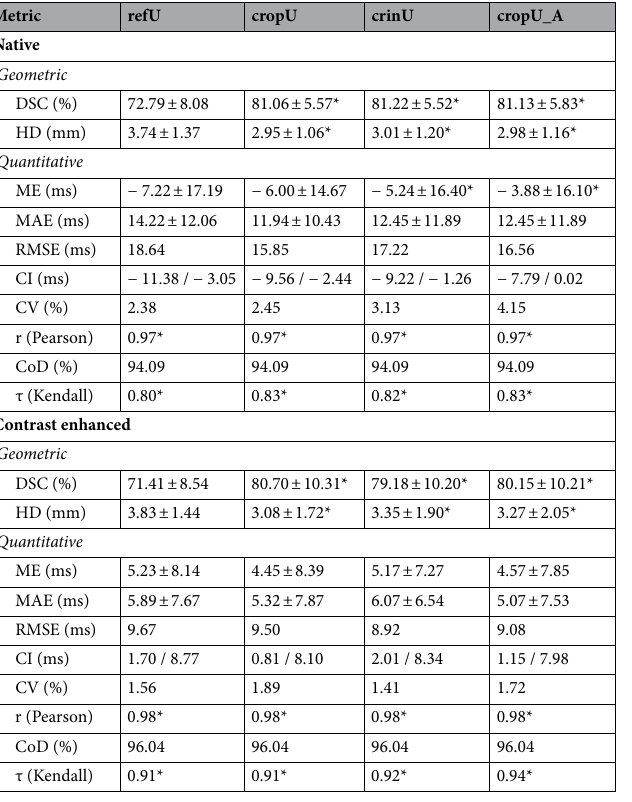
Table 2. Overview of the geometric and quantitative results for refU, cropU, crinU and cropU_A in the T1 map test dataset separated for native and contrast enhanced T1 maps. DSC dice similarity coefficient,